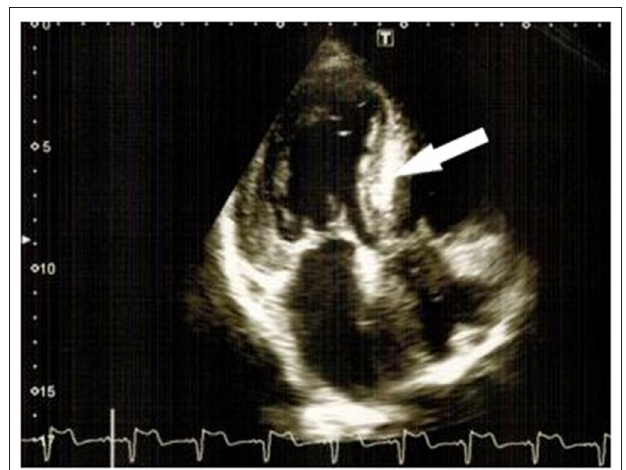
FIGURE 3 | “Characteristic luminescence” of the interventricular septum (bold arrows) and left ventricle hypertrophy.